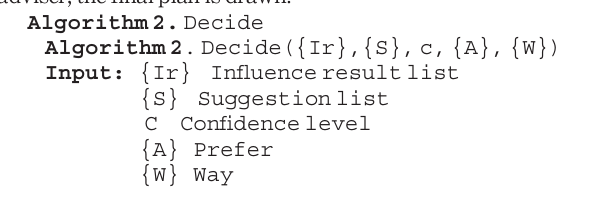
Algorithm 2. Decide Algorithm 2 . Decide({Ir},{S}, c, {A},